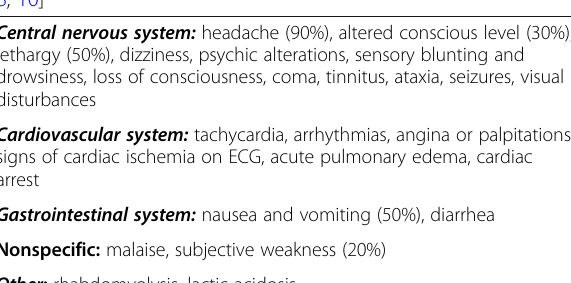
Seasonality, evaluation of the possible sources of mon- oxide production (to be searched with the eye and inves- tigated) is listed in Table